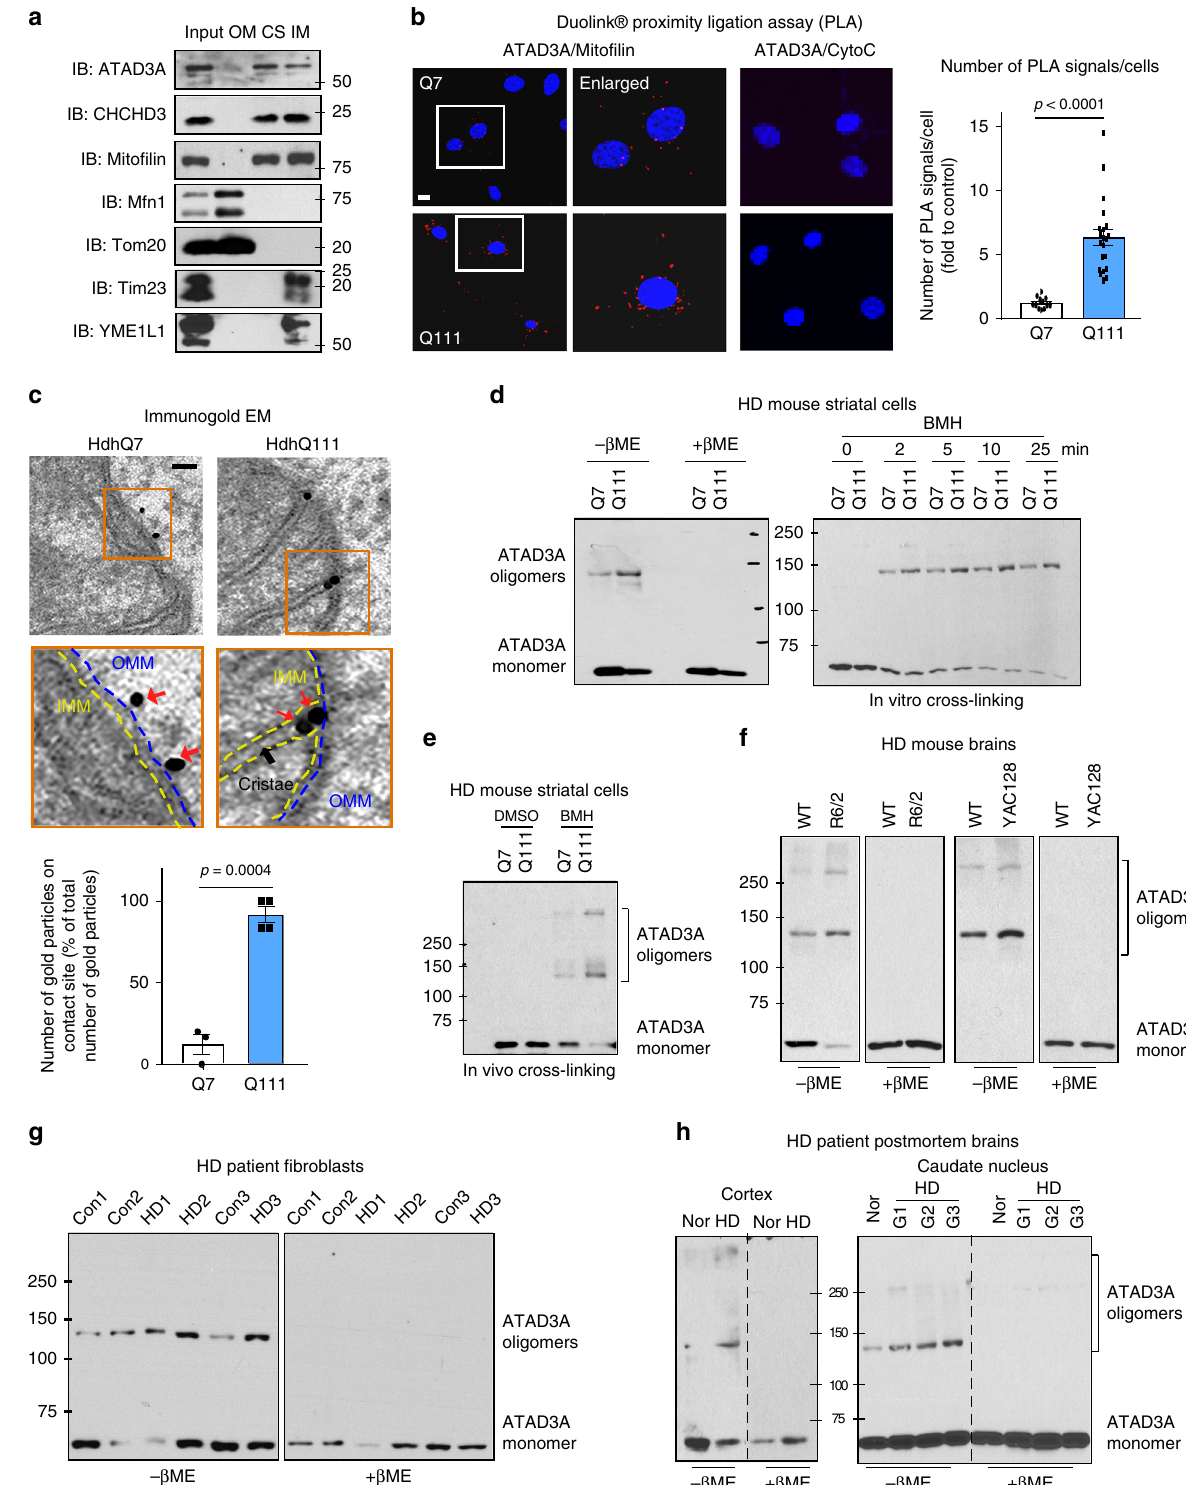
ATAD3A oligomerization impairs mtDNA maintenance in HD . ATAD3A tightly maintains mtDNA nucleoids 13,17 . Expres- sion of ATAD3A Δ N50 mutant decreased the number of nucleoids immuno-positive for both anti-DNA and anti-Tom20 antibodies. In contrast, cells expressing Δ CC mutant exhibited a similar number of nucleoids as those in cells expressing control vector or ATAD3A WT (Fig. 3c, d). Expression of Δ N50 NATURE COMMUNICATIONS| (2019) 10:1371